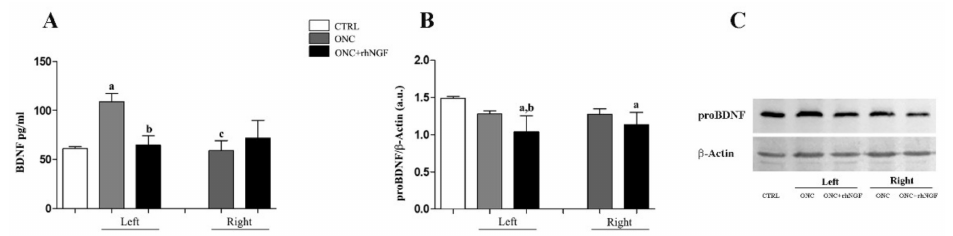
Figure 4. Effecs of ONC and rhNGF treatment on BDNF. BDNF concentration measured by ELISA and the results of WB analysis of proBDNF in VCx of CTRL, ONC, and ONC+rhNGF are shown in graphs ( A , B ), respectively. BDNF is expressed as pg/mL protein, and proBDNF is expressed as optical density (arbitrary units, a.u.). A representative gel for proBDNF is reported in ( C ). Data are presented as mean ± S.D. Statistically different: a vs. CTRL; b vs. ONC; c left vs. right VCx (same treatment